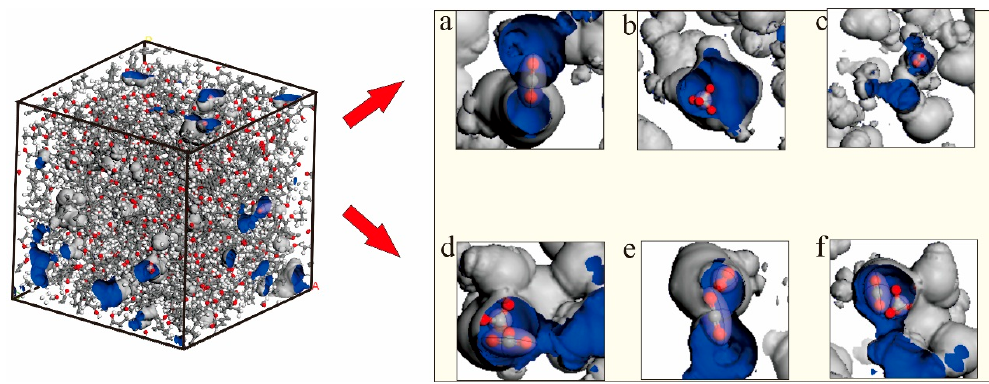
Figure 10. Different adsorption positions of CO 2 /CH 4 /N 2 . ( a ) Only CO 2 were present in the pore. ( b ) Only CH 4 were present in the pore. ( c ) Only N 2 were present in the pore. ( d ) CH 4 and CO 2 were both in the pores. ( e ) N 2 and CO 2 were both in the pores. ( f ) CH 4 and CO 2 were both in the pores.